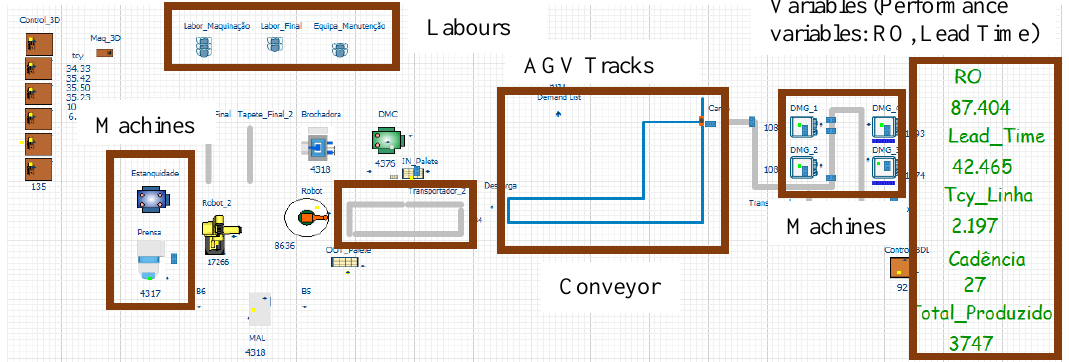
Figure 13. Witness model of layout 2. Table 2. Performance measures of the 4